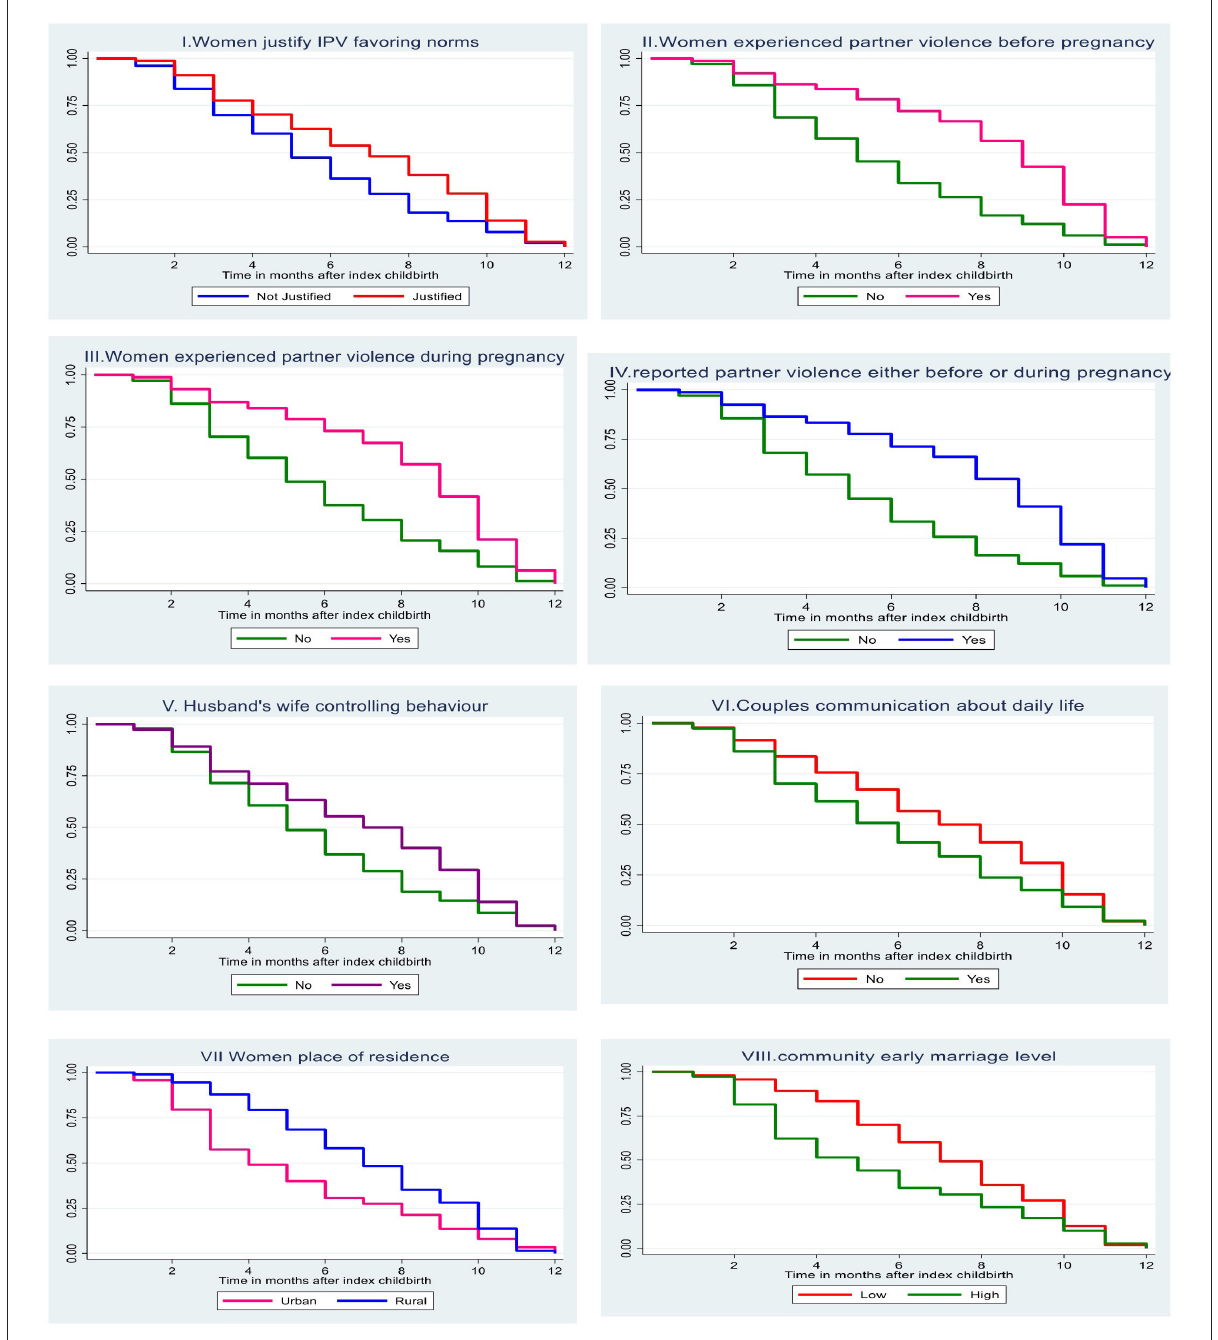
FIGURE2 Kaplan-Meier estimate curves for postpartum contraception timing between index childbirth and 12 months by selected characteristics among married women.